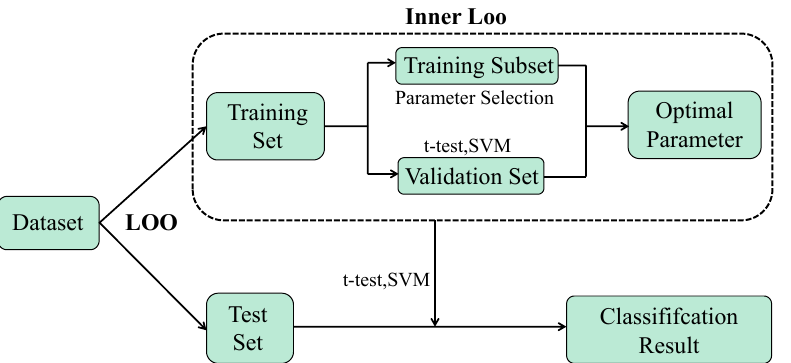
Figure 2. The cross-validation mechanism used in our experiments includes the internal LOO method to determine the best parameters and the external LOO method to obtain classification